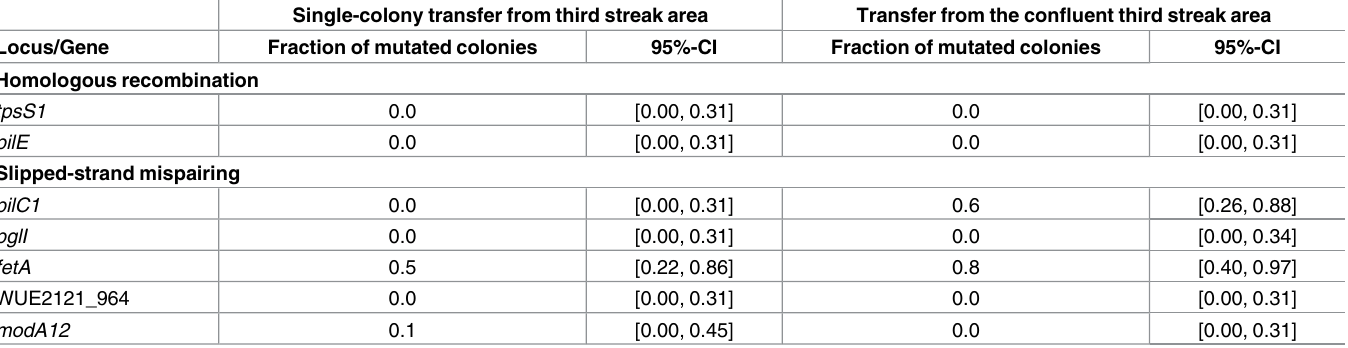
Table 3. Gene sequence differences in ten colonies of strain WUE2121after five in vitro passages using the semiquantitative streakmethod com- pared to the initial